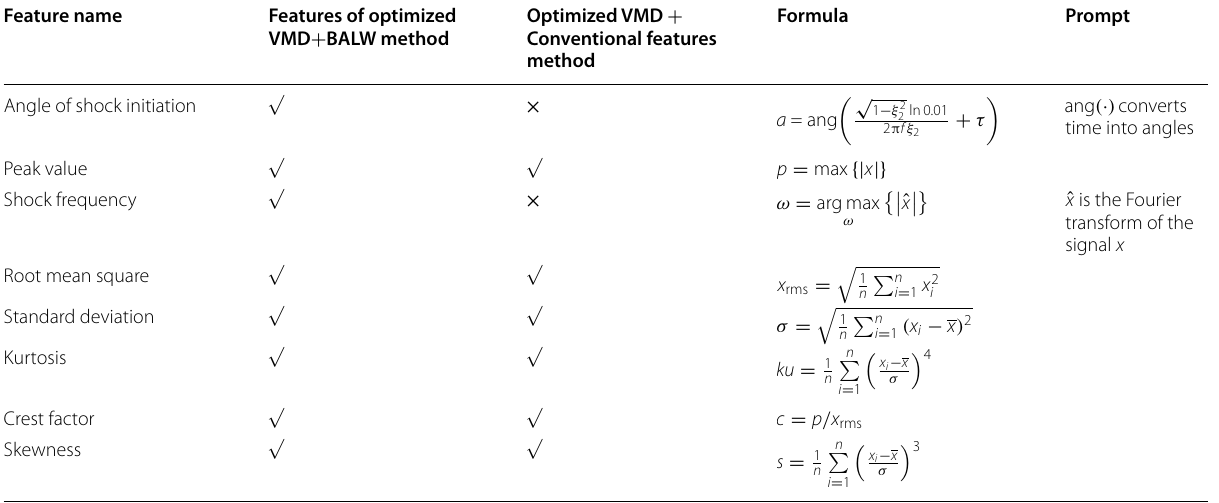
Table 4 Features of different methods